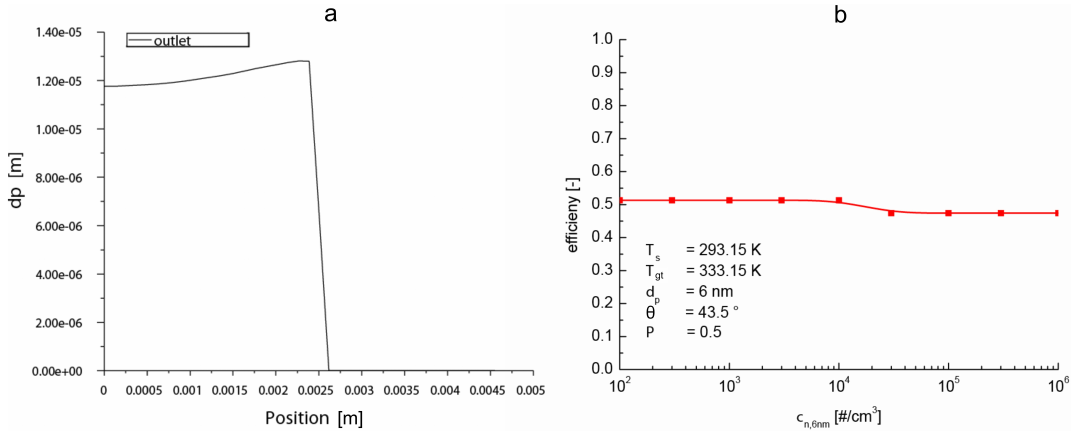
Fig. 4. Radial distribution of particle size at the growth tube outlet (a) and CPC counting efficiency as a function of inlet particle number concentration (b) assuming a unimodal inlet size distribution.